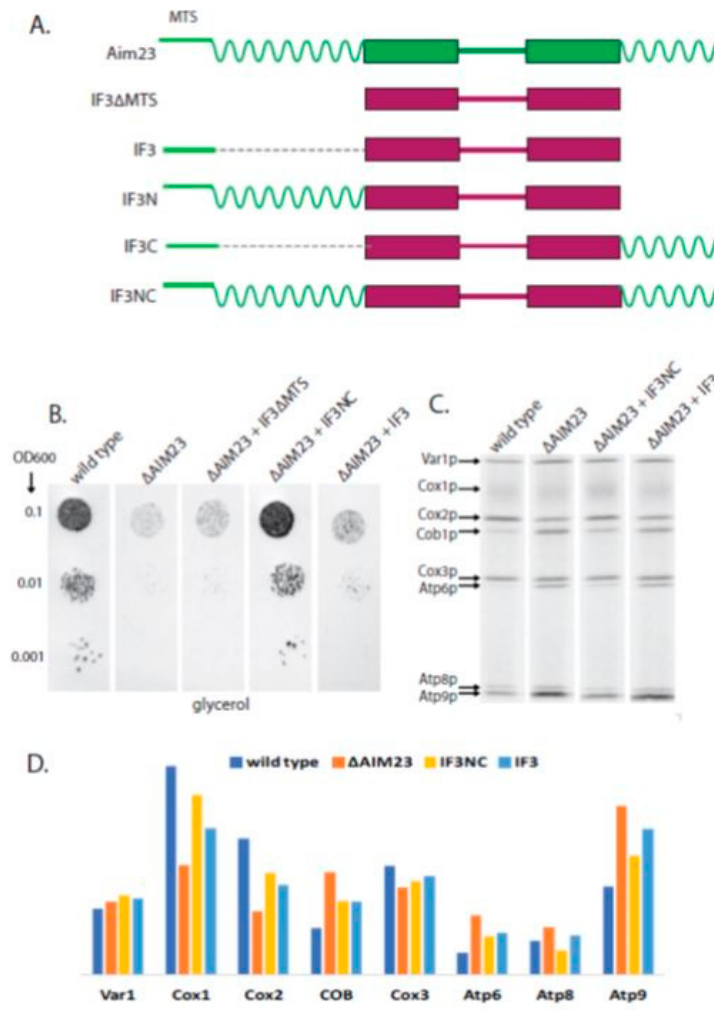
Figure 3. Aim23p terminal extensions fused to bacterial IF3 restore the biological activity of the chimeric protein in yeast cells. ( A ) Scheme of the chimeric proteins (the names are indicated on the left). The designations of the main structural parts and their colors are the same as in Figure 1. ( B ) The plate with a glycerol-containing medium after 2 days of growth of the yeast strains indicated on the top. The ten-fold dilutions of the yeast suspensions were plated, starting from OD600 0.1 (indicated on the left). Wild-type and ∆ AIM23: see Figure 2 legend. All other strains: D273-10B with the AIM23 genomic disruption supplemented with the corresponding mutant Aim23p version